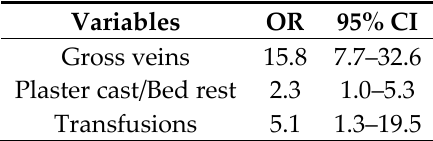
Table 1. Logistic